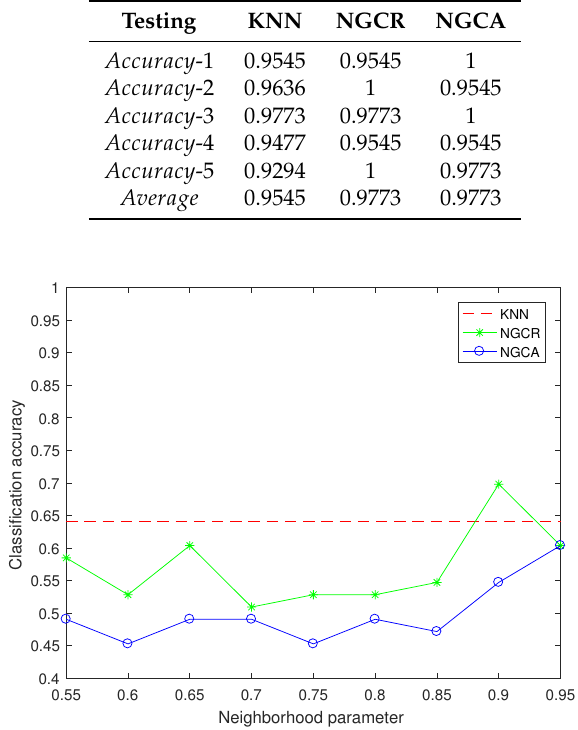
Figure 5. Classification accuracy for the glass